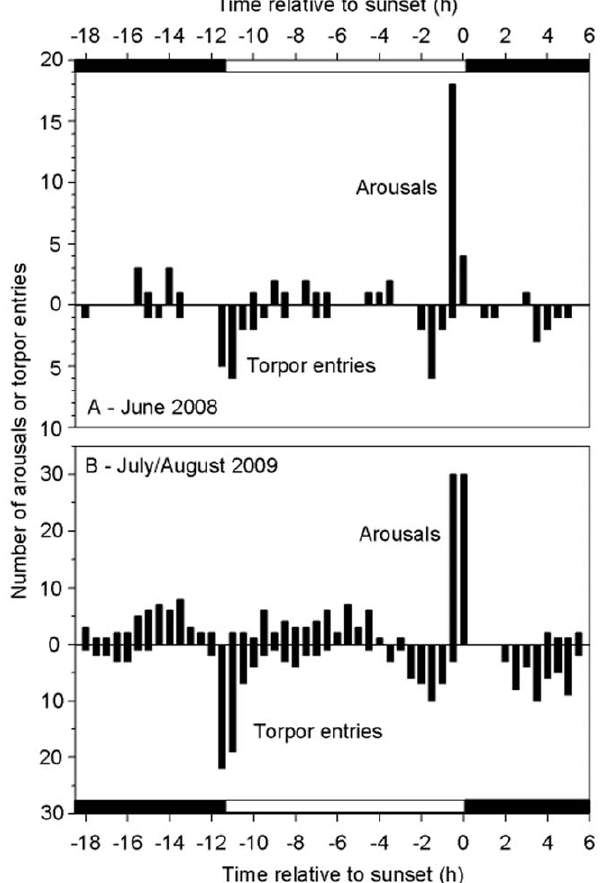
Figure 4. Timing of activity and torpor. Distribution of times of arousals from torpor (top half of graphs) and entries into torpor (bottom half of graphs) of N. bifax during (A) June 2008 and (B) July/ August 2009 relative to the time of sunset (0 hours). Each individual contributed several points to these graphs, ranging from 2 to 41 data points. Each bar represents a 30 minute period. The horizontal black and white bars at the top and bottom of the graphs represent night and day,